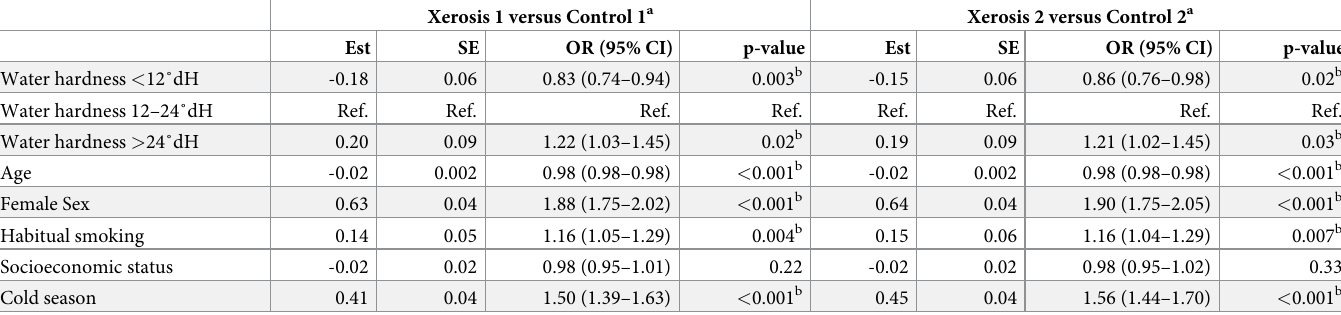
Table 3. Adjusted multinominal regression model with xerosis as